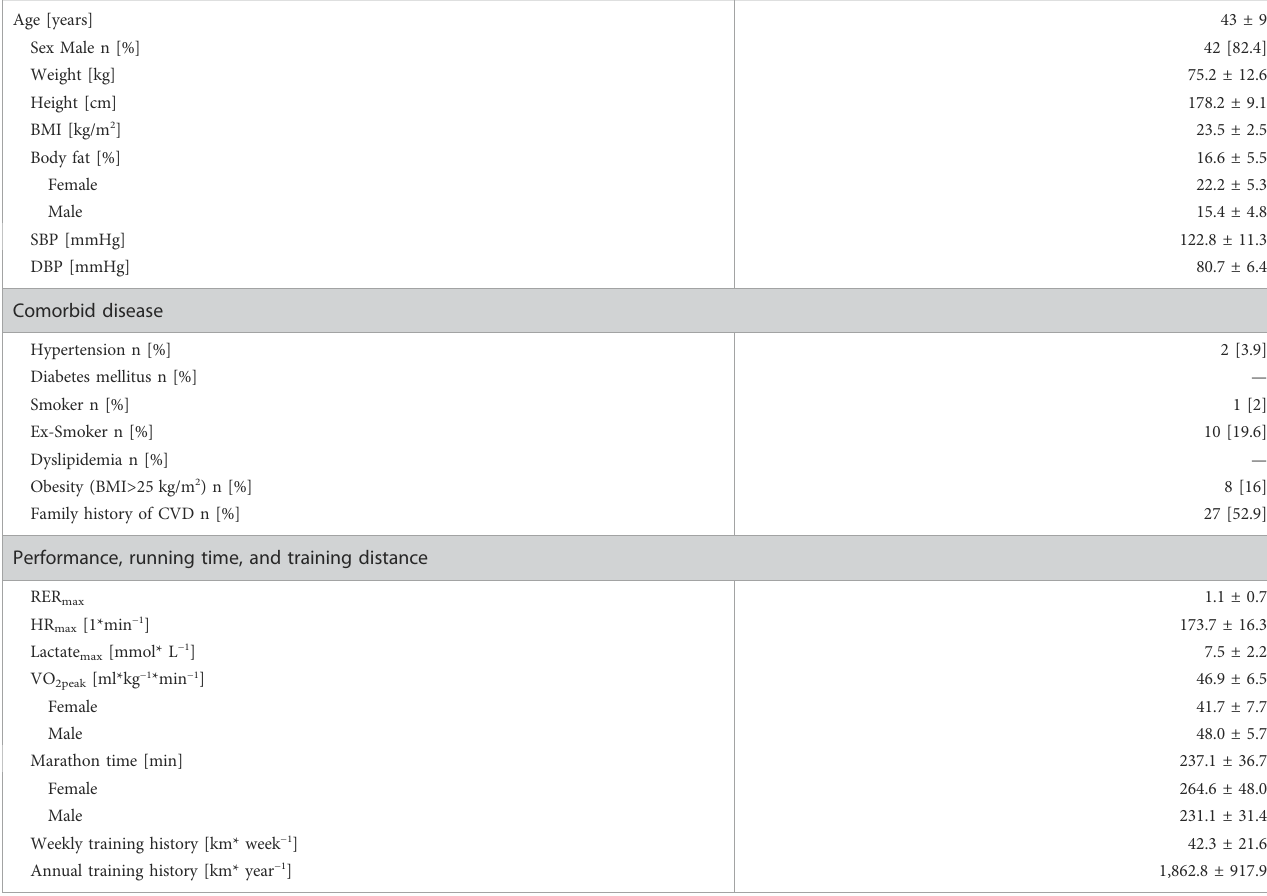
TABLE 1 Baseline characteristics of the study